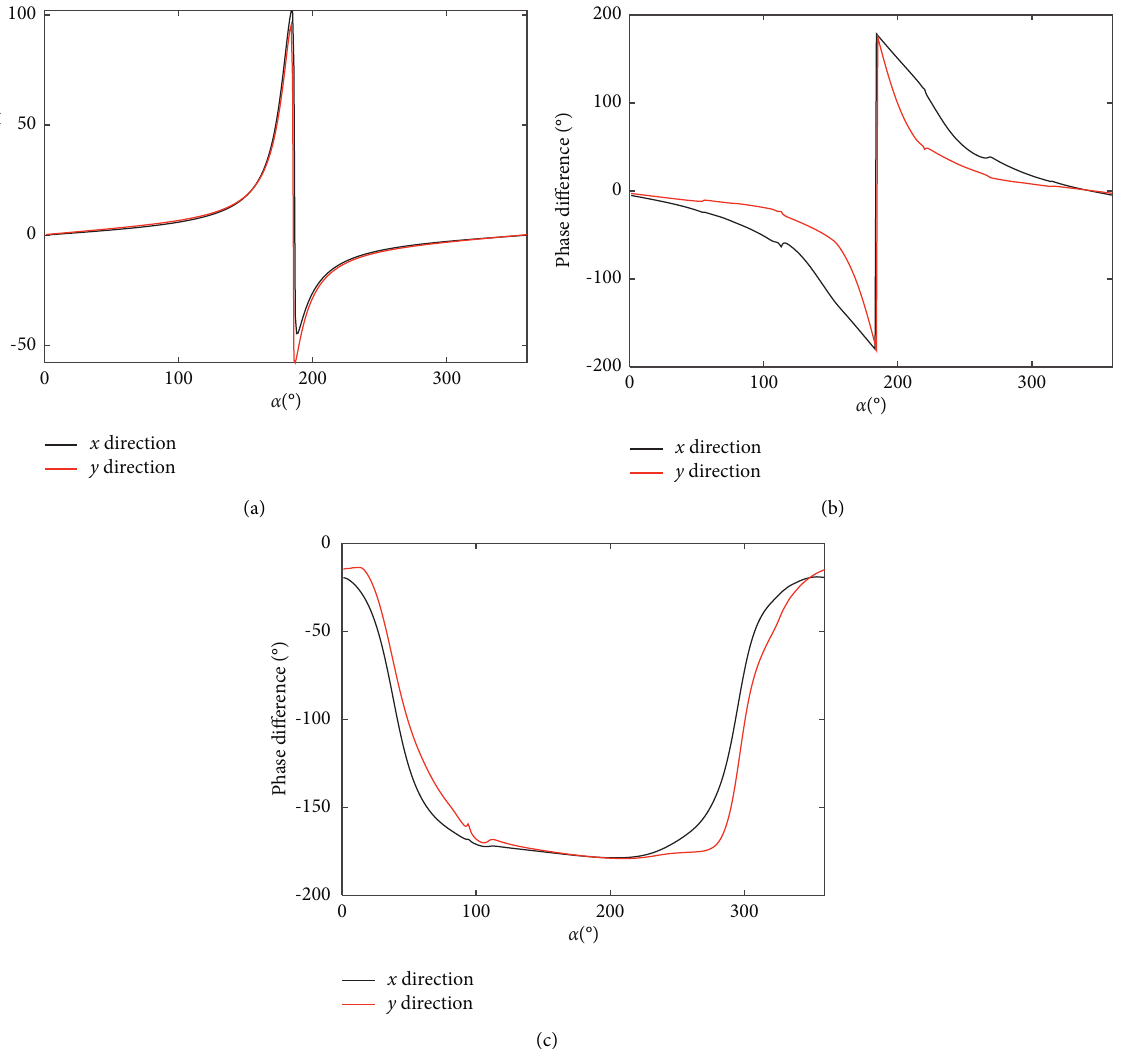
Figure 14: Variation curve of bearing phase varying with α : (a) 2000rpm; (b) 5000rpm; (c)